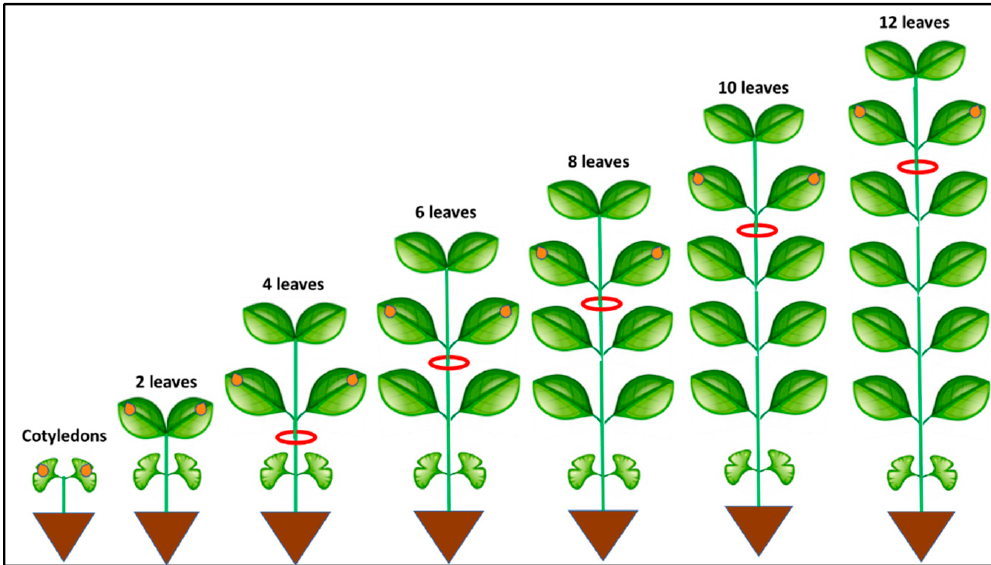
Figure 1. Experimental design for testing the systemic spread of Peronospora belbahrii in basil plants. Plants of various ages, from the cotyledons stage to the 12-leaf stage, were inoculated on two leaves per plant with two 10 µL droplets (orange dots) each containing 100 sporangia of the pathogen. The inoculated pair of leaves were located above the red ring on the stem. The inoculated plants were incubated in a dew chamber to allow infection and thereafter at 25 ◦ C to develop systemic infection. Water-inoculated plants served as